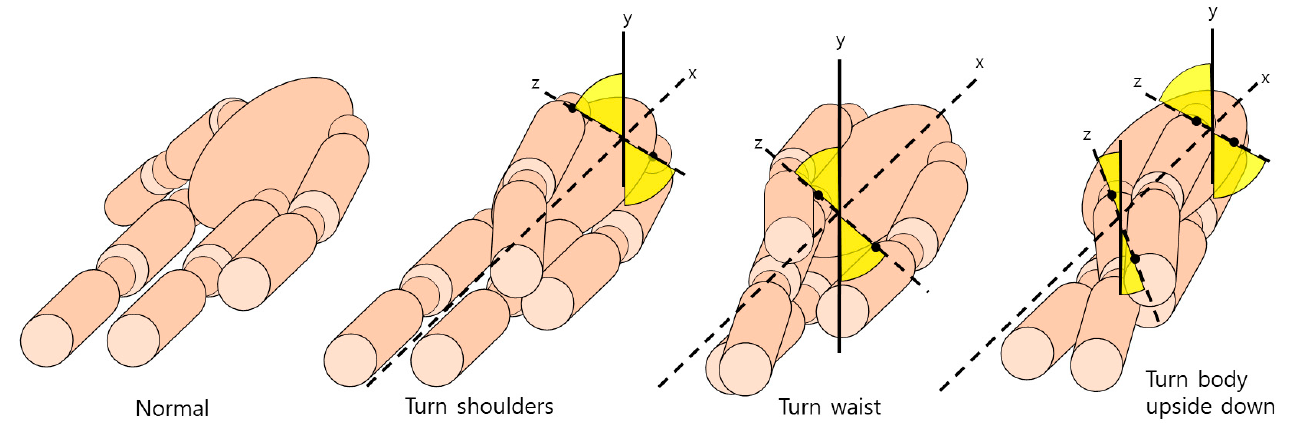
Figure 6. An image indicating a method of detecting the rotation direction of the hip joint based on the spine.